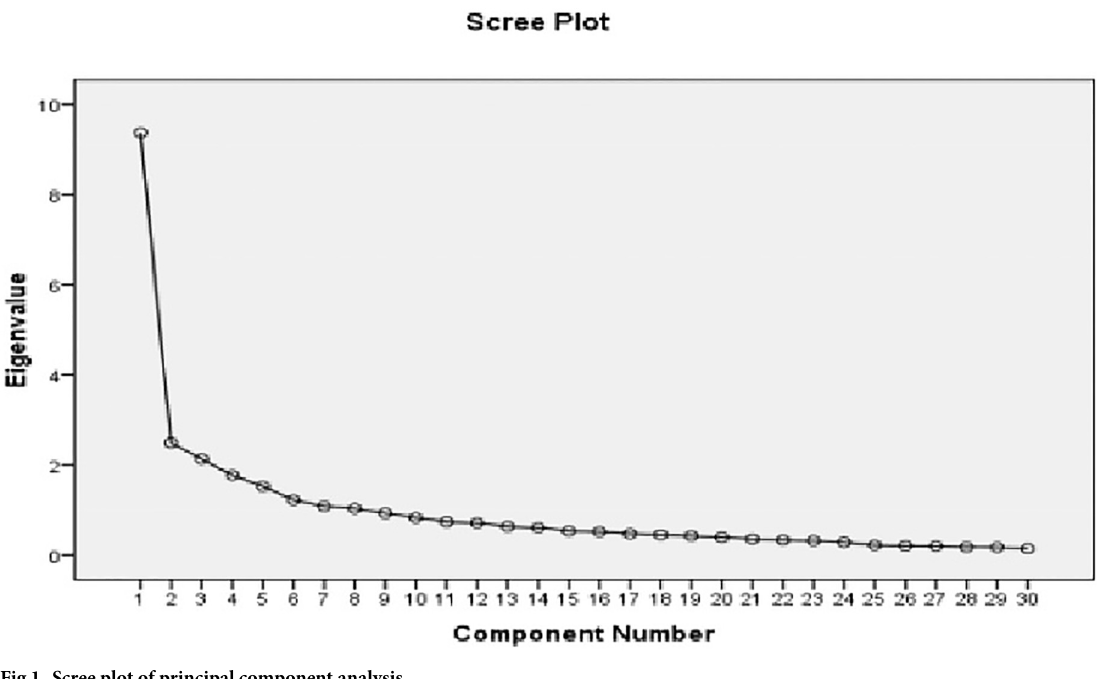
Fig 1. Scree plot of principal component analysis.